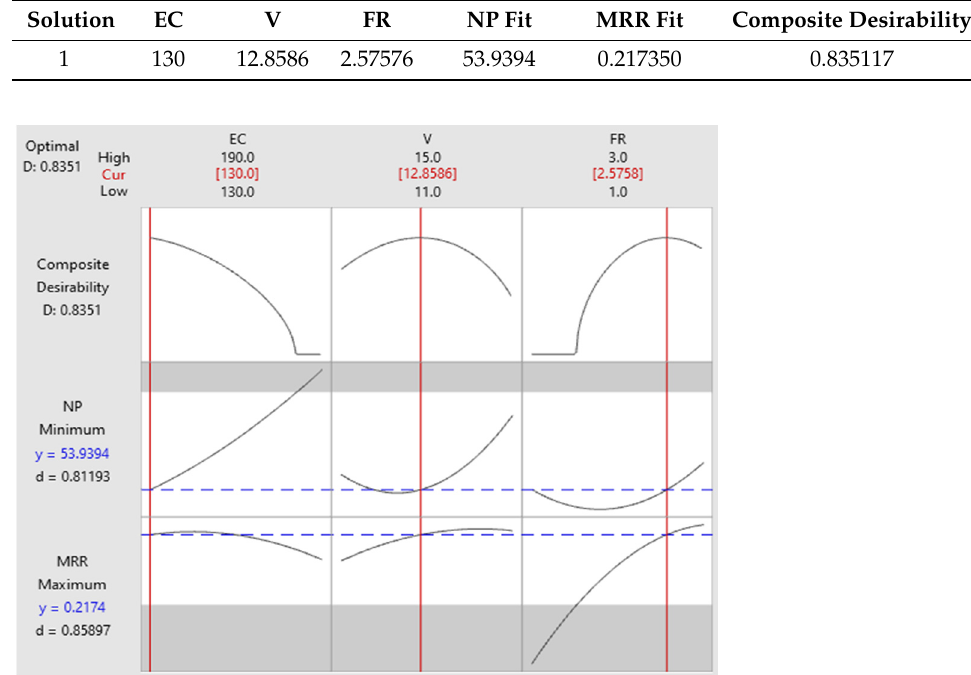
Table 9. Multiple response prediction results using RSM.